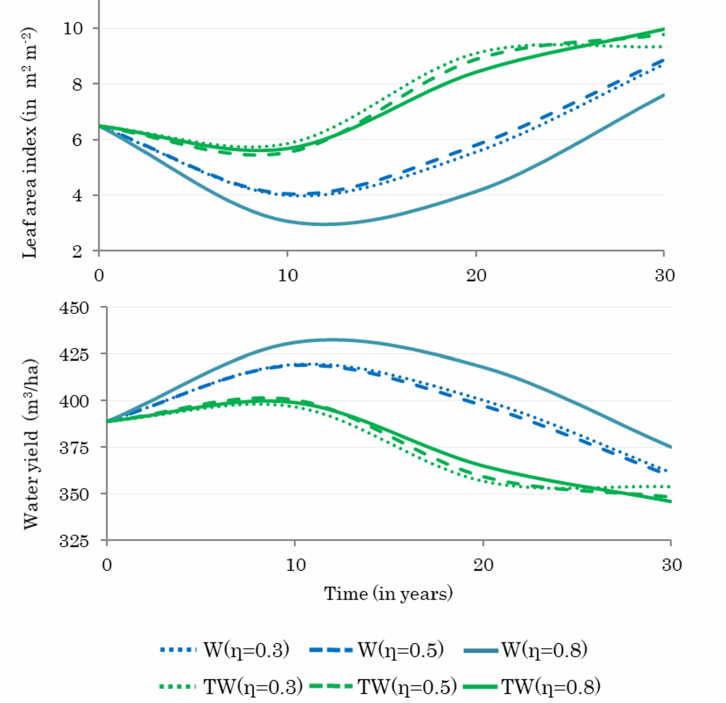
Figure 7. Evolution of the leaf area index and water yields over a 40-year time horizon by optimization scenario (Results for the water (W) and joint timber and water (TW) maximization scenarios, a discount rate 4%, and maximum harvesting rates ( η ) of 0.3, 0.5 and